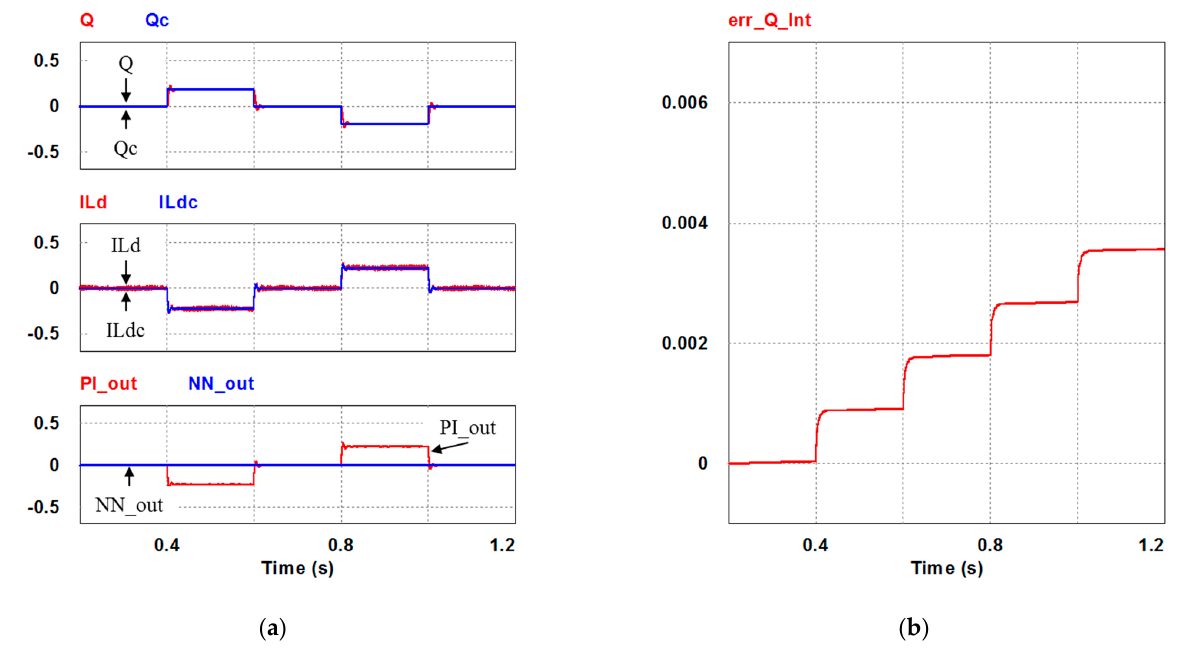
Figure 16. Case 1 simulation result: ( a ) reactive power feedback and its command, inductor current power and its command, and reactive power controller outputs (all control signals are in V); ( b ) the accumulated reactive power control error.